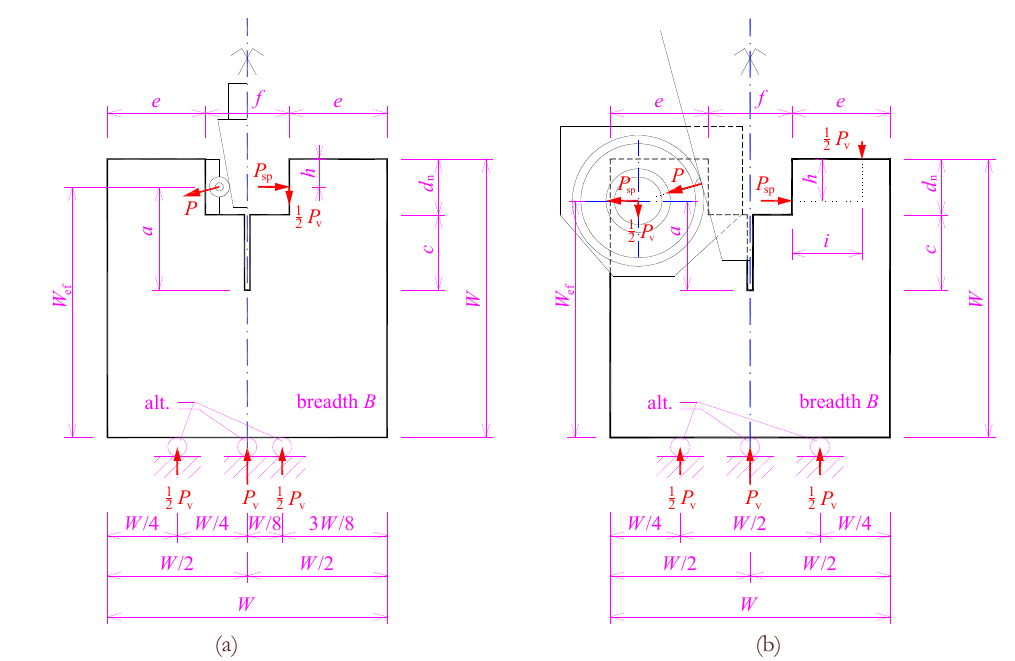
Figure 3: Sketch of the modeled WST specimen with considered variants of boundary